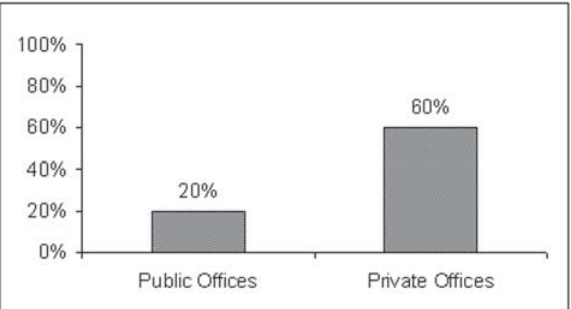
FIGURE 4- Distribution of dental professionals according to the supply of lead apron to patients during x-ray